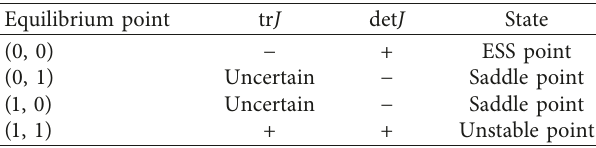
Table 2: Evolutionary stability of local equilibrium points in Scenario